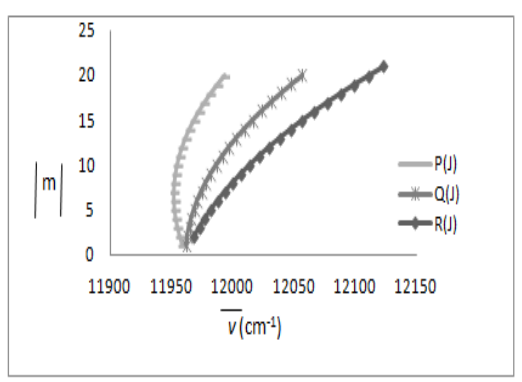
Fig.6: Fortrat parabola of BeO molecule for B 1 Σ + - A 1 Π